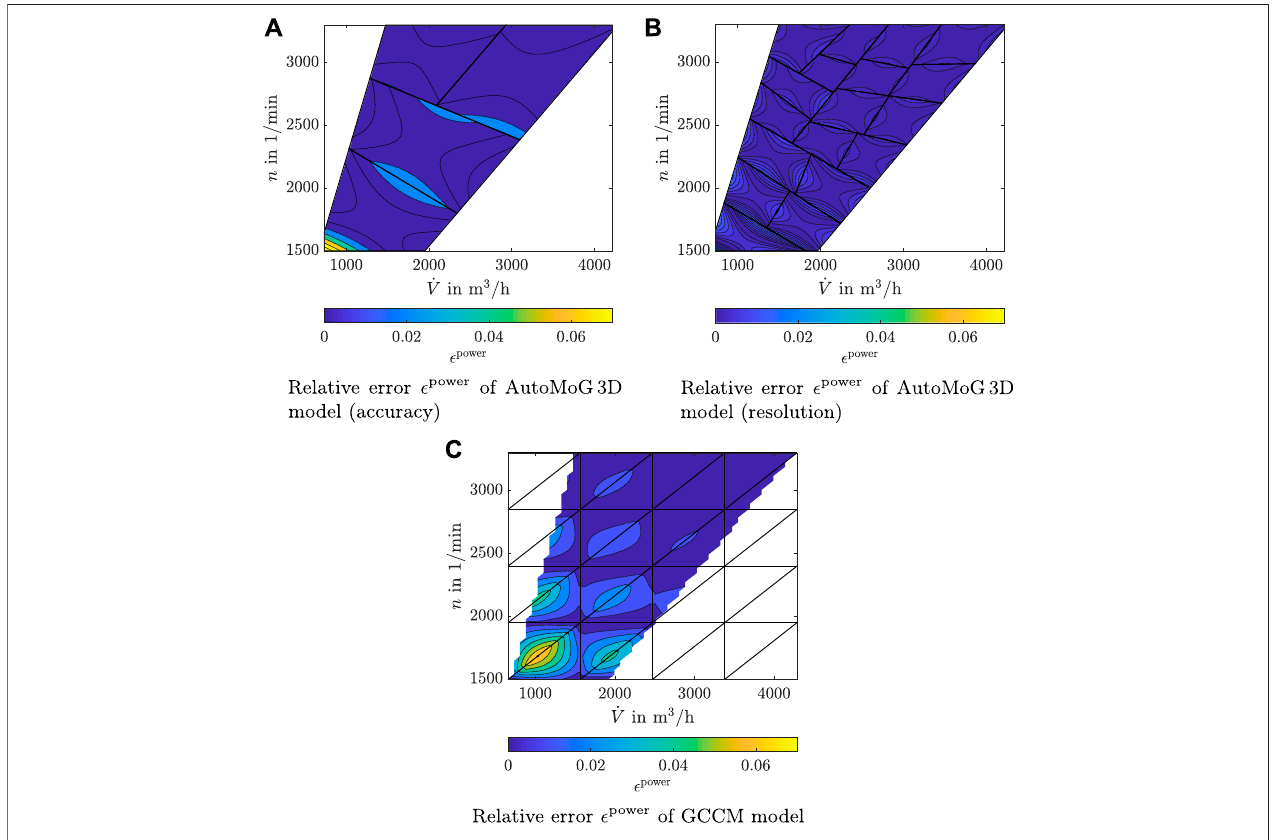
FIGURE 7 | Relative error of the AutoMoG3D model with same accuracy (A) and comparable resolution (B) compared to the relative error of the generalized- convex-combination method (GCCM) model (C) for the power function of a variable-speed pump.